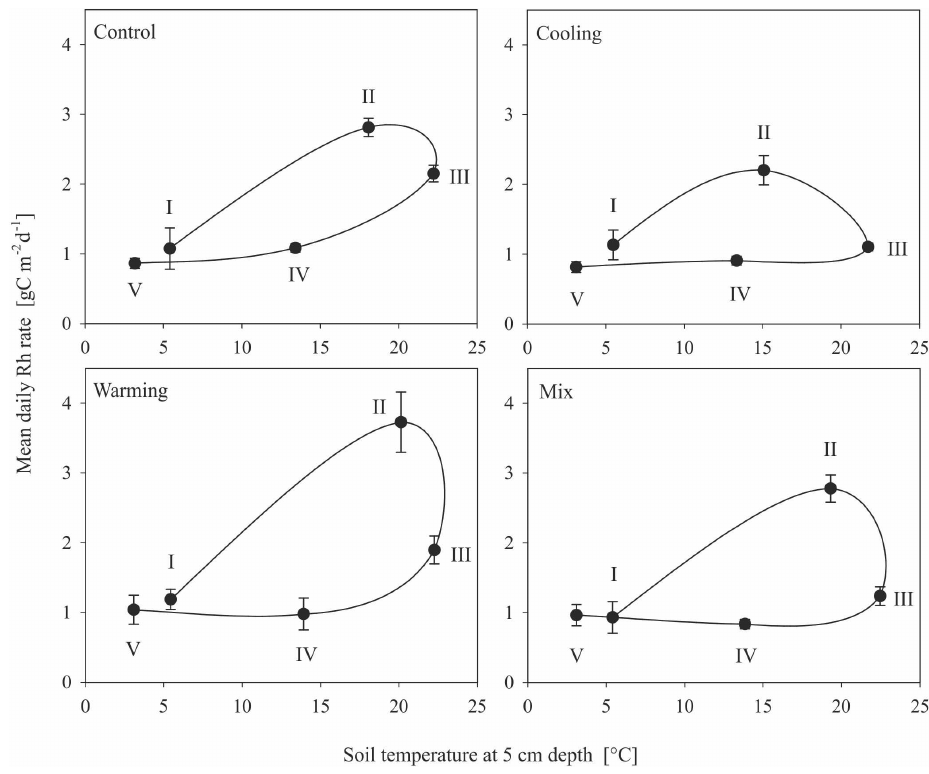
Fig. 4. Heterotrophic respiration rates vs. soil temperature at 5cm by treatment and period (I to V). Vertical and horizontal bars represent the standard error ( n =